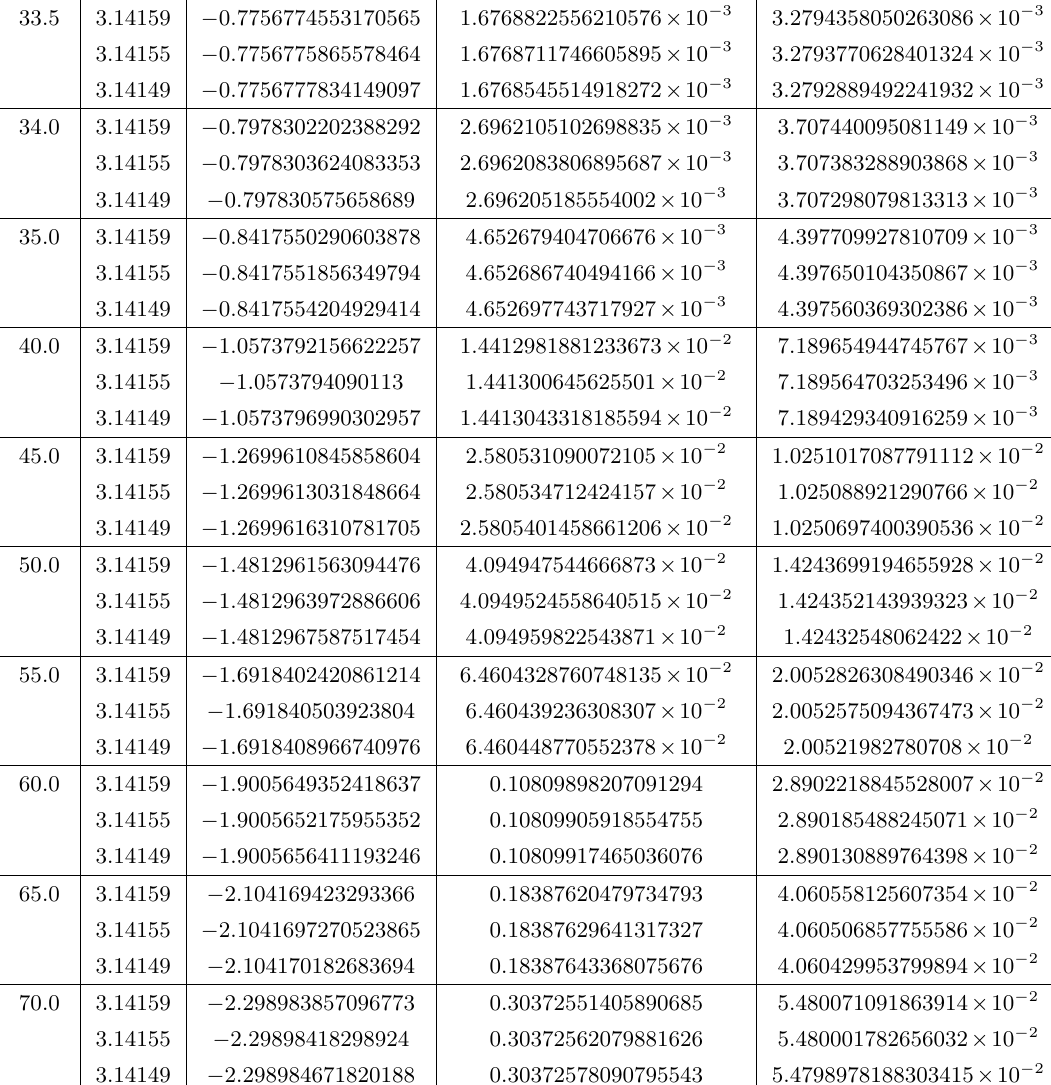
Table 4. N = 30 , partial phase at finite θ